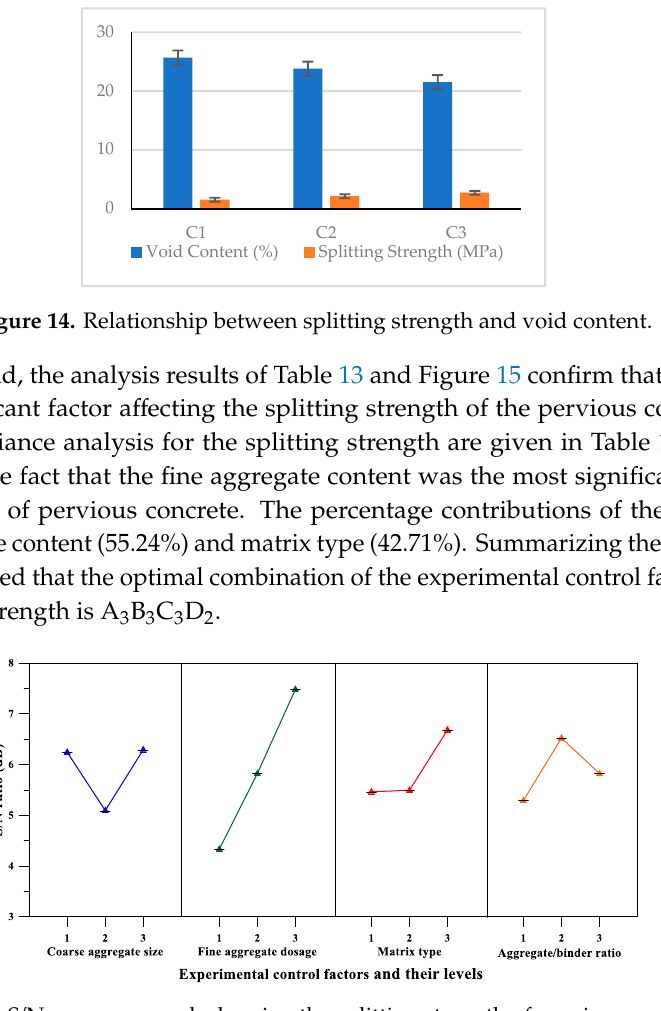
Figure 15. S / N response graph showing the splitting strength of pervious Figure 15. S/N response graph showing the splitting strength of pervious concretes.